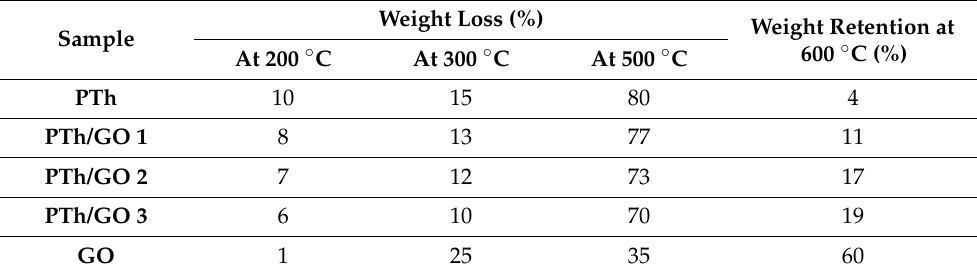
Figure 8. TGA curves: ( a ) PTh; ( b ) PTh/GO 1, ( c ) PTh/GO 2 and ( d ) PTh/GO 3 nanocomposites; ( e ) GO [87]. Table 1. TGA data for PTh, GO and PTh/GO composites